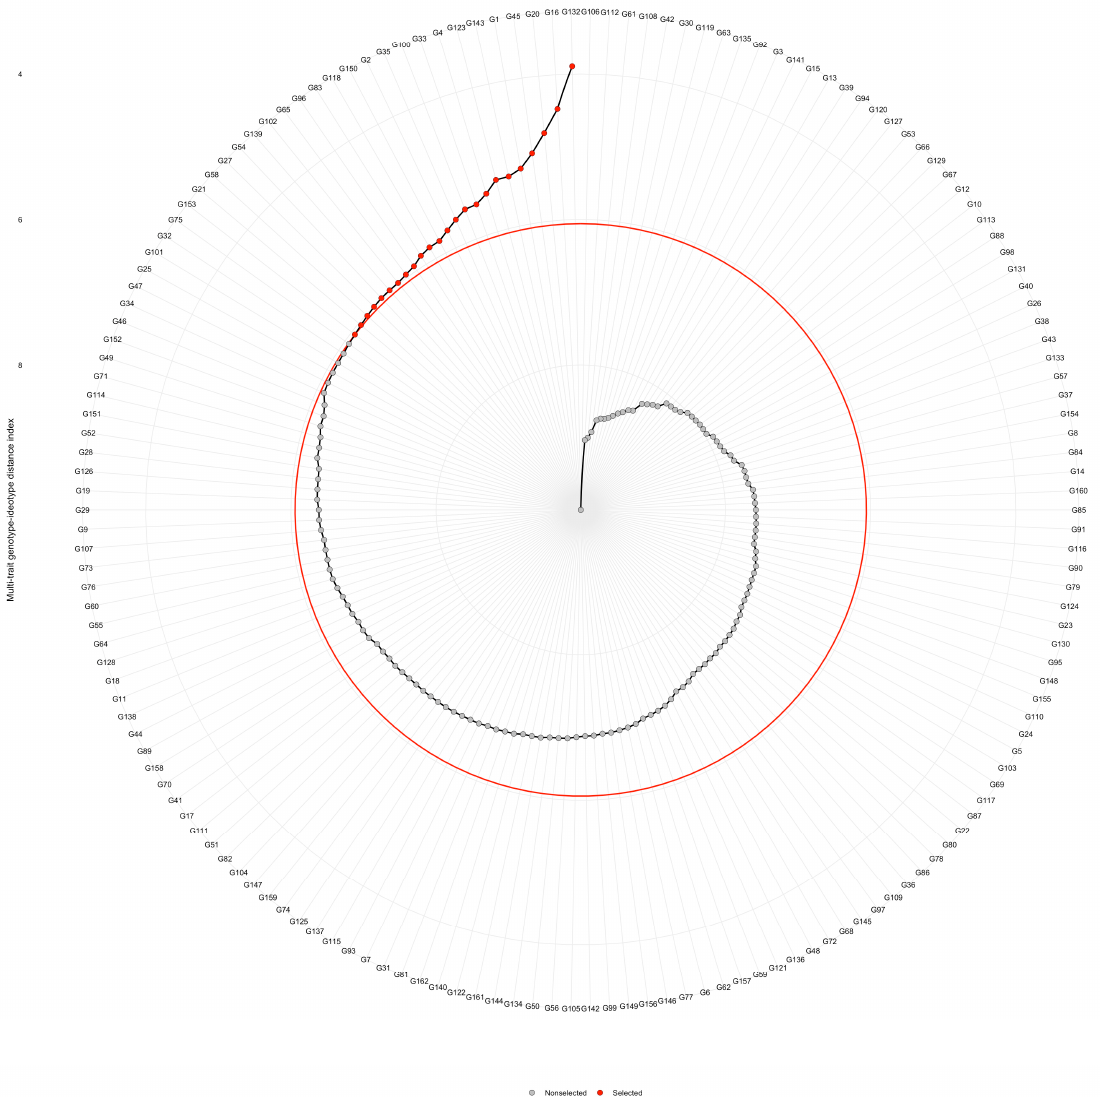
Figure 5. D. praehensilis accession rankings showing selected accessions using the multi-trait genotype– ideotype index (MGIDI). The selected accessions are shown as red dots, while the unselected ac- cessions are shown as black dots. The red circle represents the cut point according to the selection